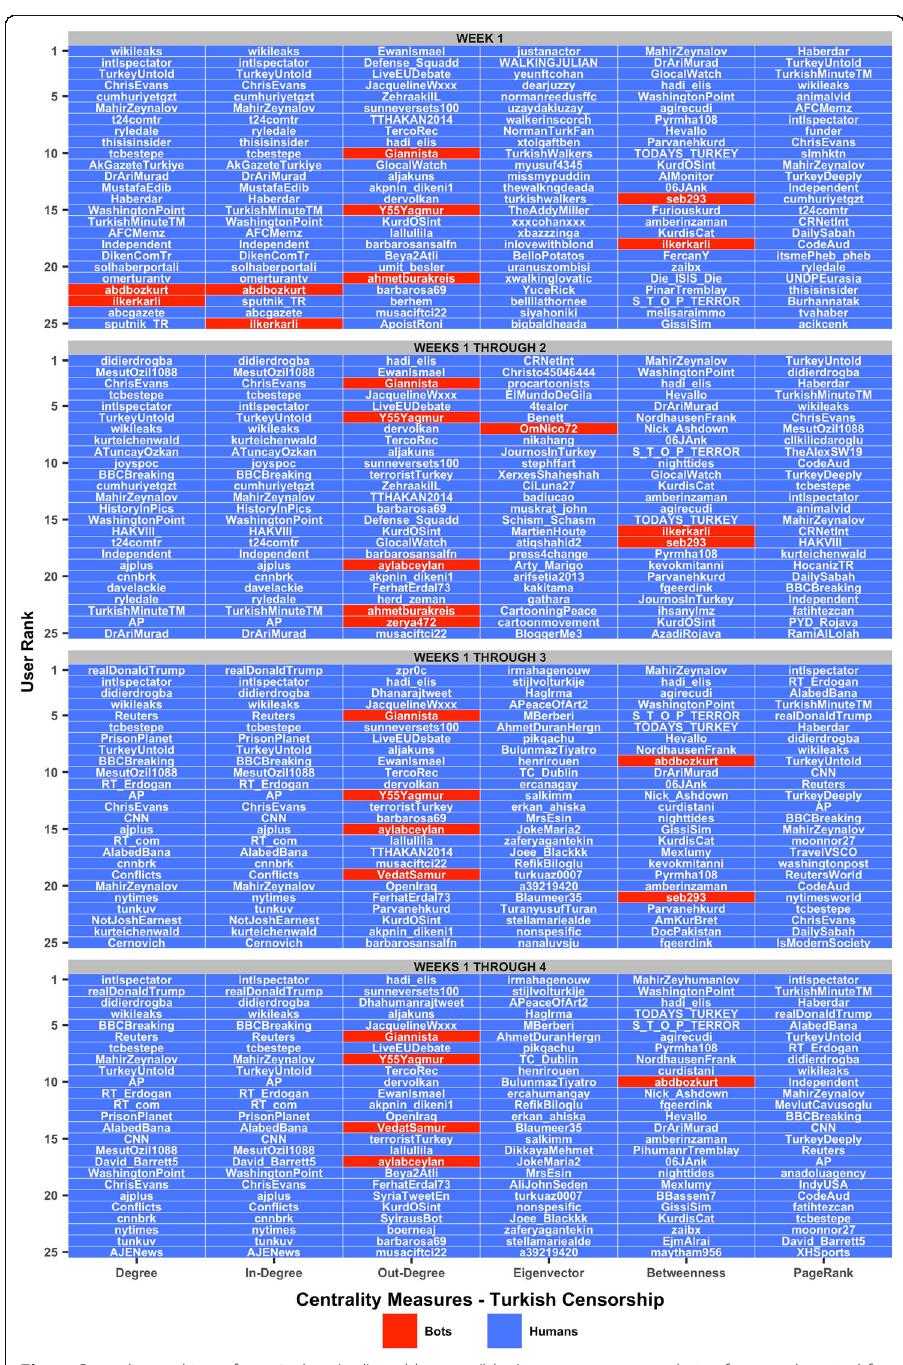
Fig. 7 Centrality ranking of top-25 bot (red) and human (blue) users over a cumulative four-week period for Turkish Censorship OSN conversation for six centrality measures: (1) degree, (2) in-degree, (3) out-degree, (4) eigenvector, (5) betweenness and (6)